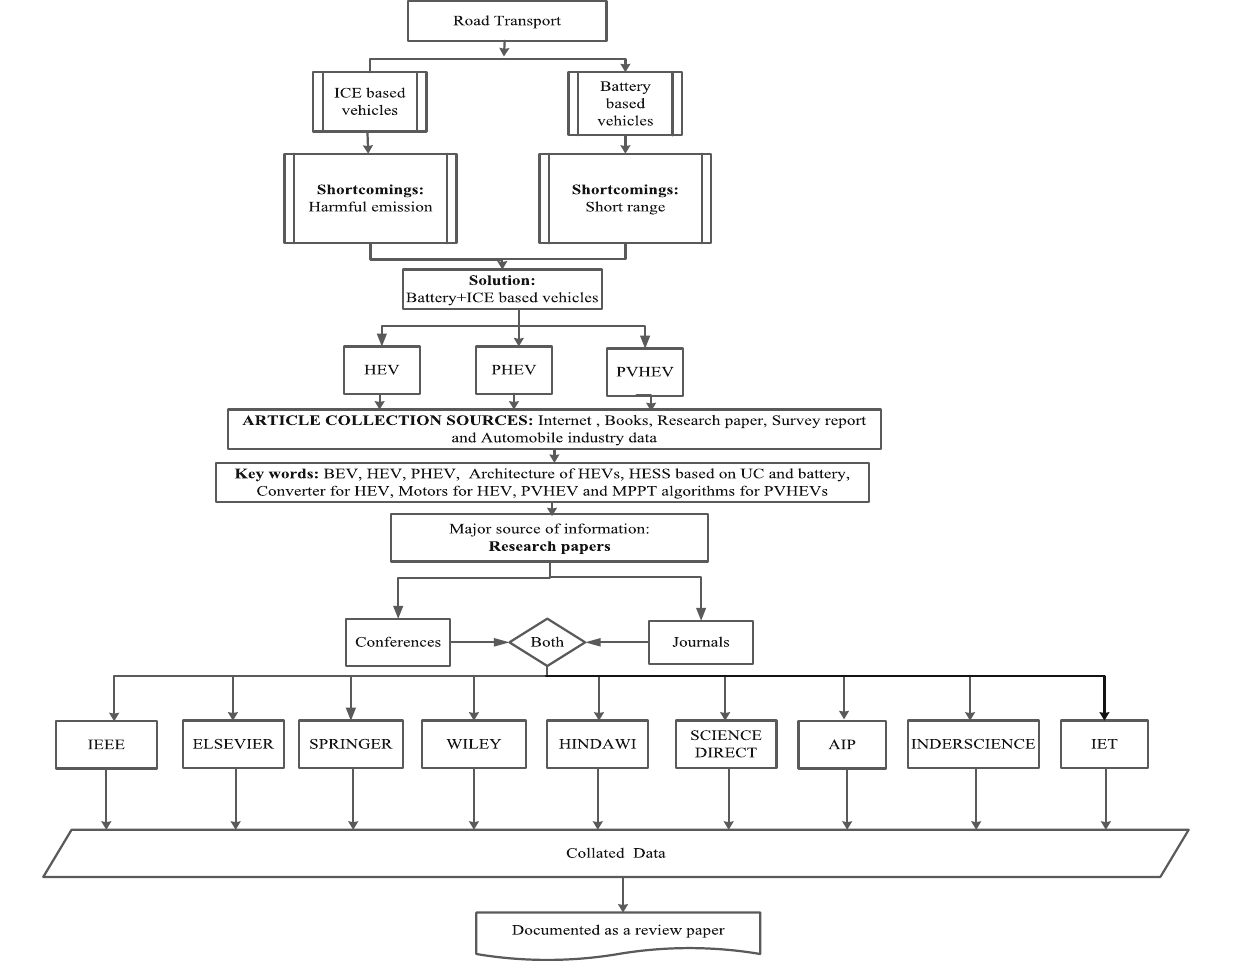
Fig. 1 Methodology adopted for constructing this review